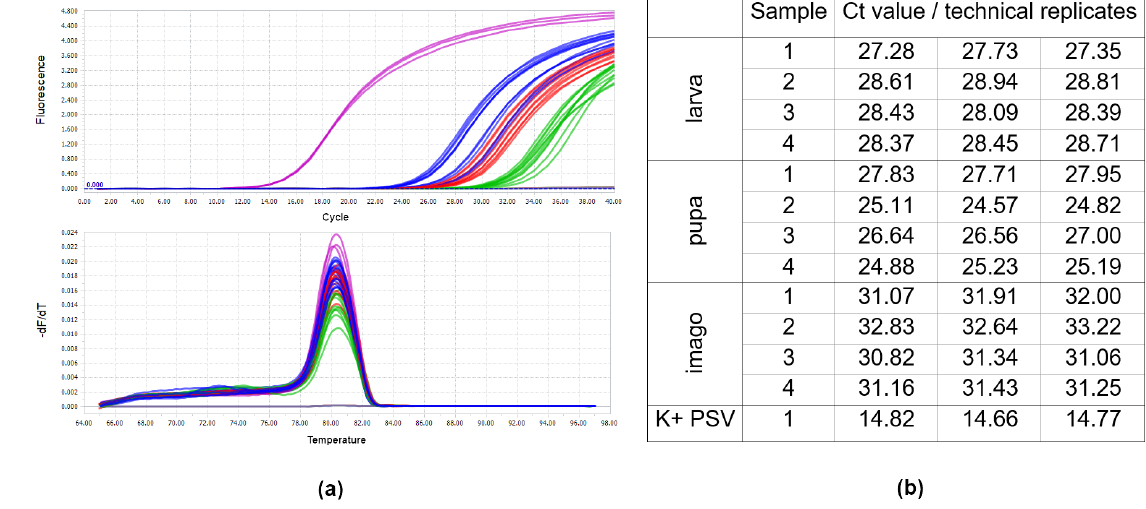
Figure 3. Results of PSV detection by RT-qPCR in single specimens of larva, pupa, and imago of B. impatiens after the virus acquisition by larvae feeding on PSV-infected N. benthamiana plants. Panel ( a ) The amplification plots of PSV 1a gene detected in a single larva—red line, pupa—blue line, imago—green line; positive control (PSV-infected N. benthamiana )— pink line (upper). Below, melting (dissociation) curves for amplicons of the PSV ORF 1a (replicase gene). For each devel- opmental stage of fungus gnat, four single specimens were analysed, in three replicates. No amplification plots were ob- tained in the case of negative controls, including healthy larva, pupa, and imago, which were not exposed to PSV as well in NTC—no template control—grey line. Panel ( b ) Table with Ct values obtained by using in RT-qPCR analysis for PSV